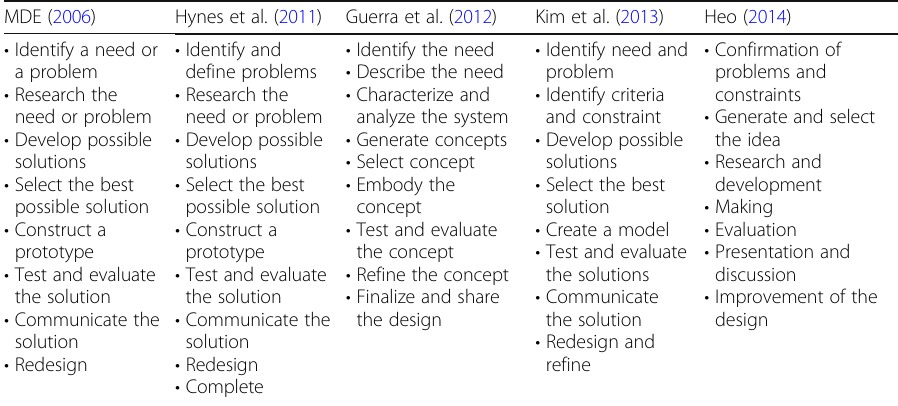
Table 3 The stages of engineering design for students suggested by science education